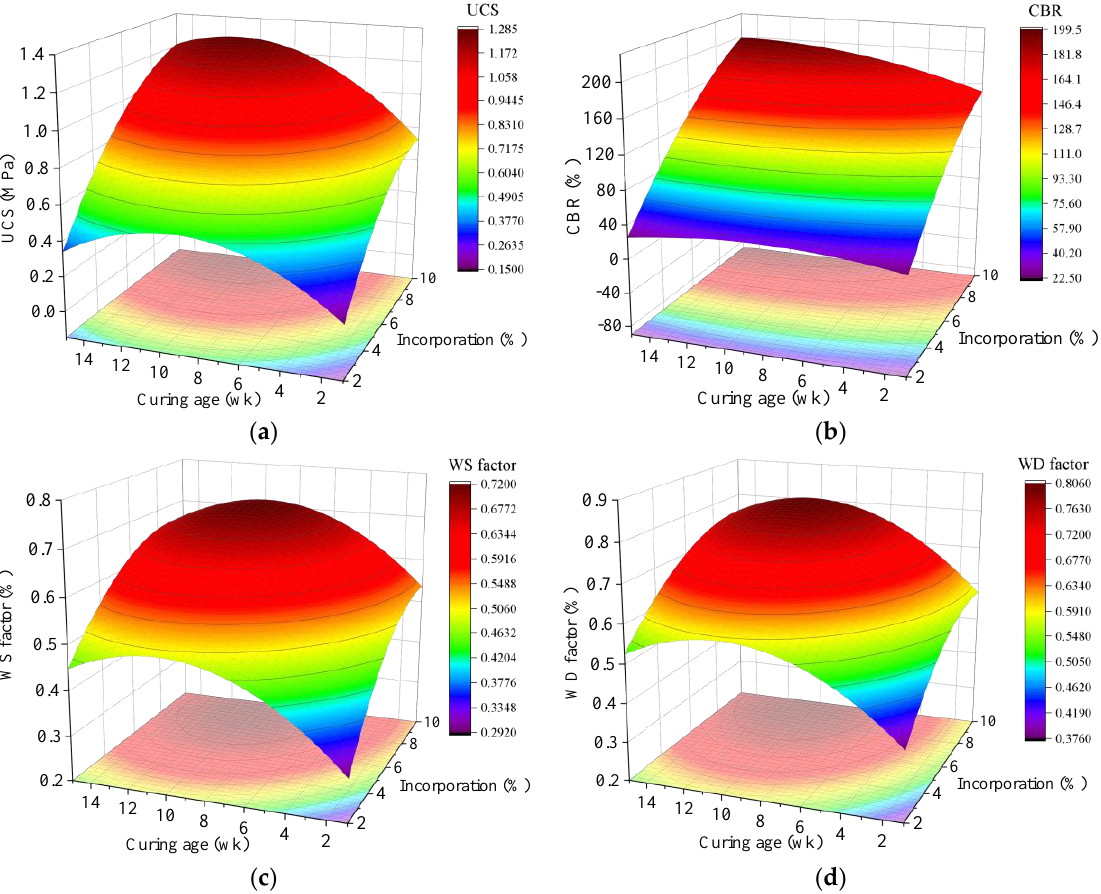
Figure 10. Effect of incorporation and curing age on ( a ) UCS, ( b ) CBR, ( c ) WS factor and ( d ) WD factor. Table 4. The results of variance analysis.